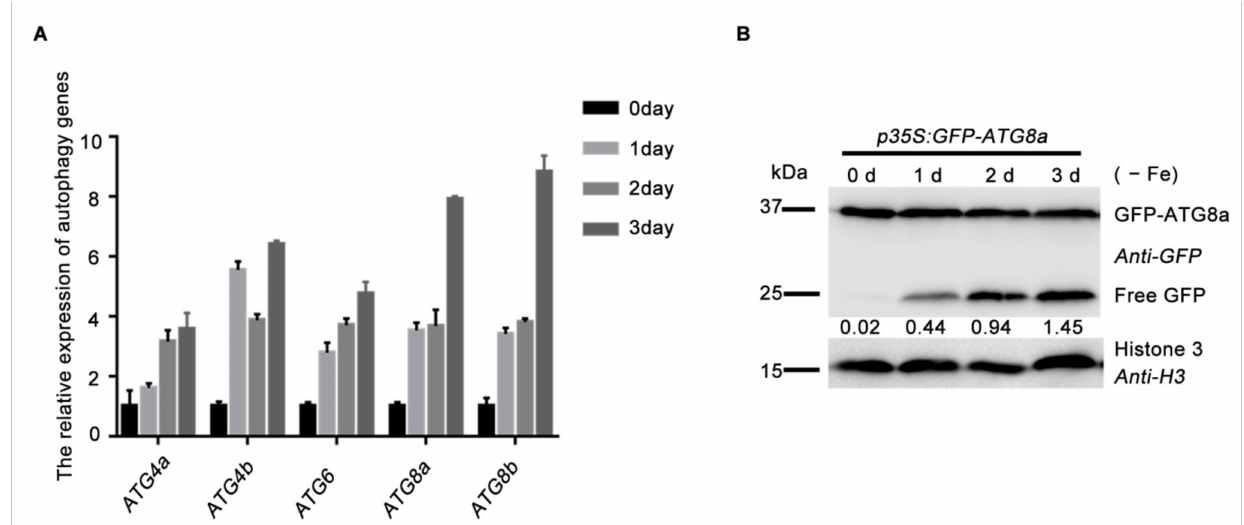
Figure 6. Iron-deficiency promotes the activity of autophagy. ( A ) Gene expression profile of ATGs in 7-d-old Clo-0 seedlings exposed to iron starvation for 0 d, 1 d, 2 d and 3 d. Overall gene expression levels of ATGs were increased. Data represent the mean ± SEM from three independent experiments. ( B ) Immunoblot analysis of autophagic flux in response to Fe starvation. Seven-d-old GFP-ATG8a seedlings grown on 1/2 MS + Fe medium plates were transferred to 1/2 MS − Fe liquid medium for treatment 0 d, 1 d, 2 d and 3 d followed by protein extraction and immunoblot analysis. Values below the blots represent the ratio of free GFP to GFP-ATG8a fusions in the individual